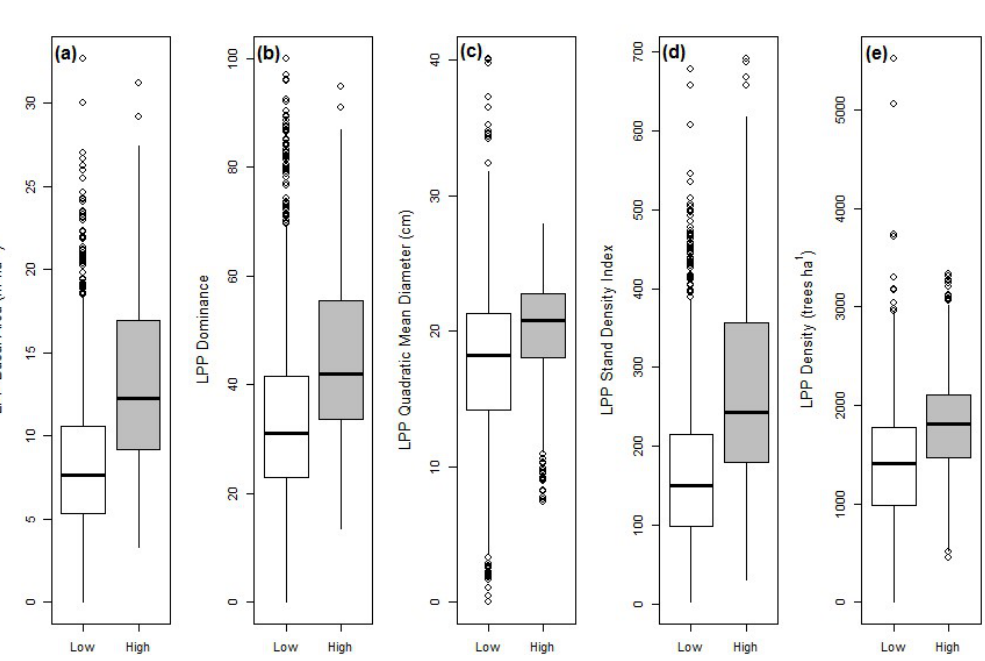
Table 2. Mean (s.e.) of stand host characteristics for attacked, unattacked, and all lodgepole pine (LPP) by subwatershed ( n = 2262). Different superscript letters indicate significantly different values between unattacked and attacked LPP ( p ≤ 0.05). See Table 1 for variable descriptions.